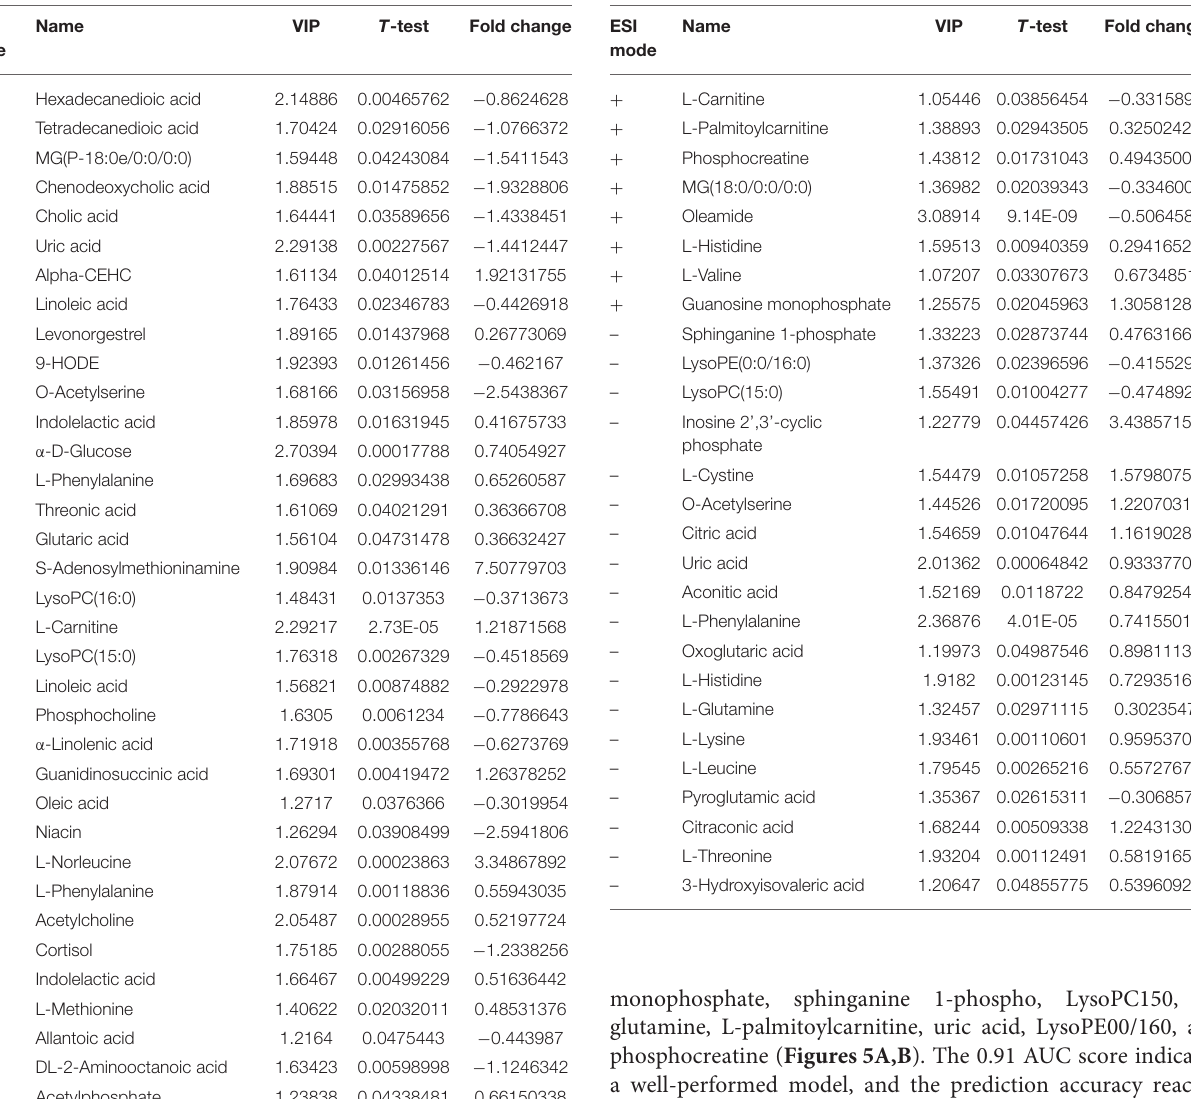
TABLE 3 | Differential Metabolites between pre- and post-operative samples of POCD